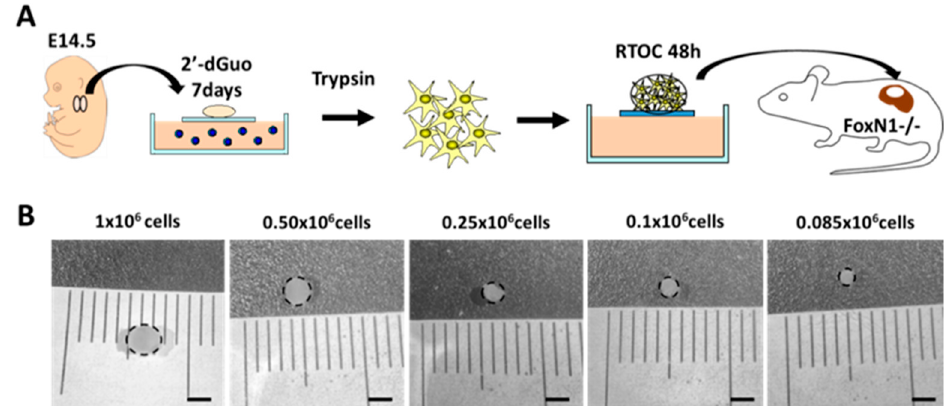
Figure 4. Diagram of reaggregate thymus organ culture (RTOC) establishment and representative images of the yielded thymi one month after grafting under the kidney capsule of FoxN1 − / − mice. ( A ) E14.5 WT thymic fetal lobes were treated with 2 ′ -dGuo. After 7 days, thymic lobes containing just stromal cells were disaggregated with trypsin and reaggregated (RTOC) using different cell numbers (1, 0.5, 0.25, 0.1, and 0.085 × 10 6 cells) and cultured for 48 h. Then, RTOCs were grafted under the kidney capsule of FoxN1 − / − mice for 1 month. ( B ) Representative RTOCs recovered one month after grafting. Notice the gradual reduction in the lobe size as compared with control RTOCs (1 × 10 6 cells). Dotted line marks the limits of RTOC. Scale bar: 2 mm.